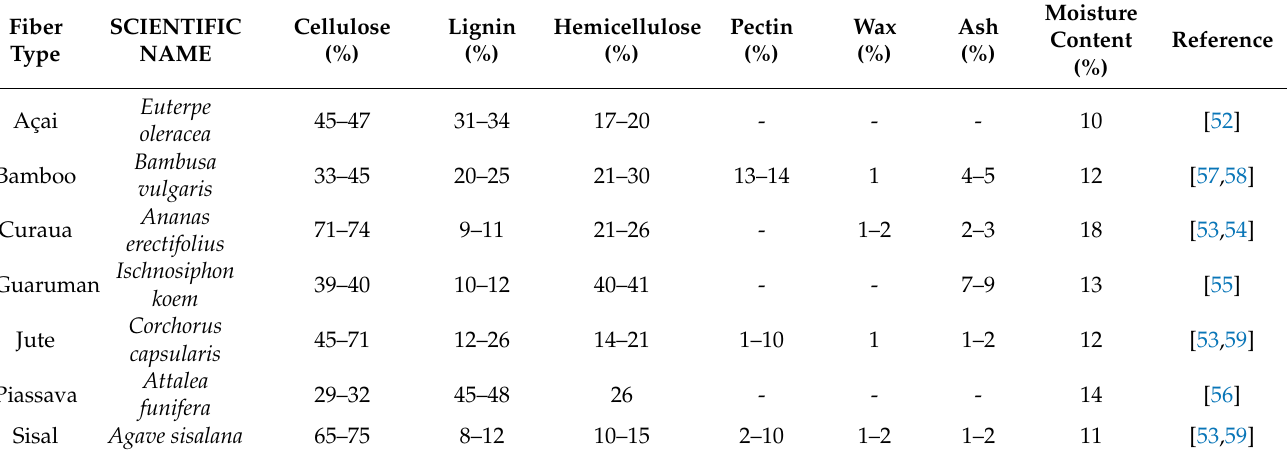
Table 1. Chemical properties of Amazon